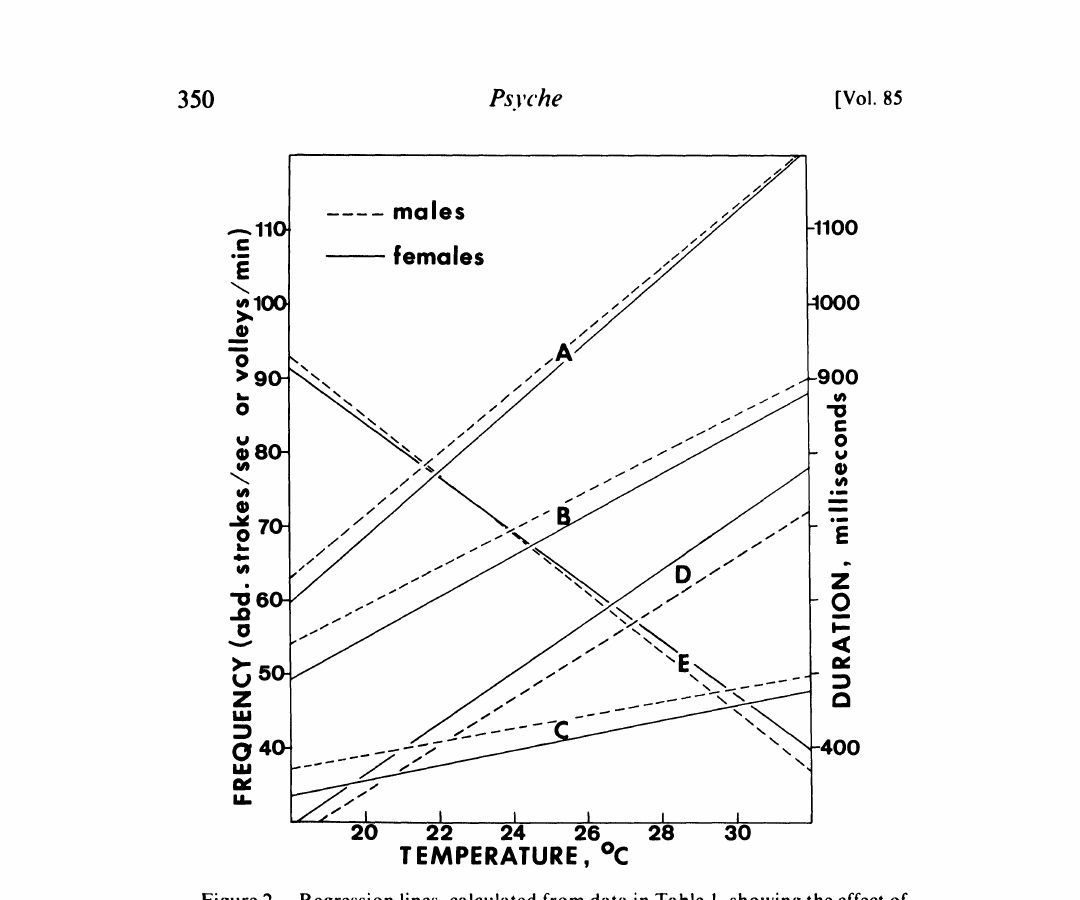
Figure 2. Regression lines, calculated from data in Table I, showing the effect of temperature on the five principal characteristics A- E of the calls of five males {dashed lines) and five females {solid line) of Ch. plorahunda. The left-hand "frequency" axis applies to parameters A-C {strokes/sec) and to D {volleys/min), while the right-hand axis for "duration" applies only to